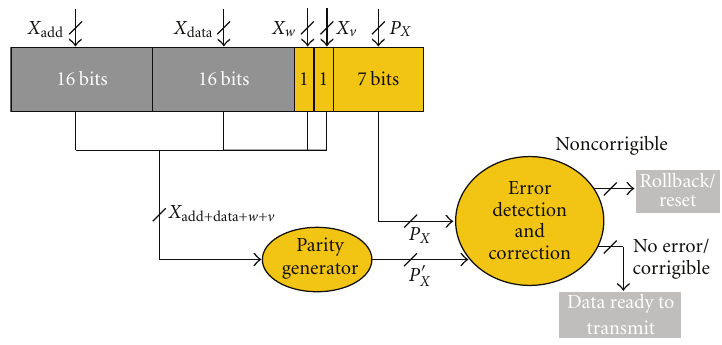
Figure 8: Error detection and correction in journal.